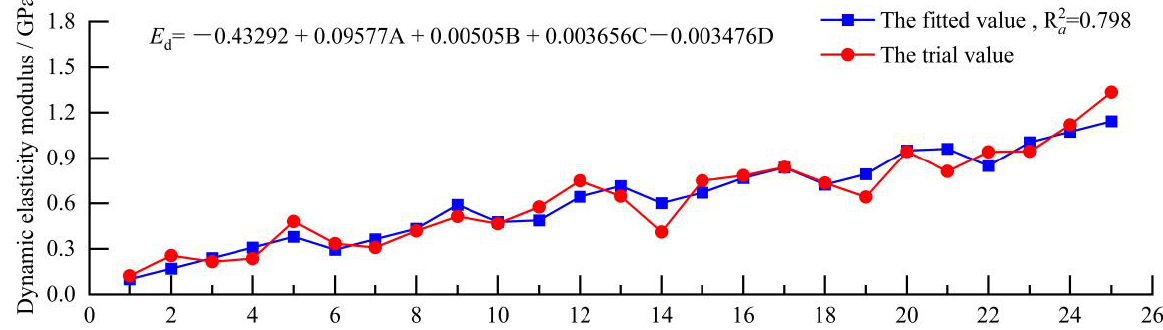
Figure 10. Comparison of fitting and experimental results for dynamic elastic modulus.